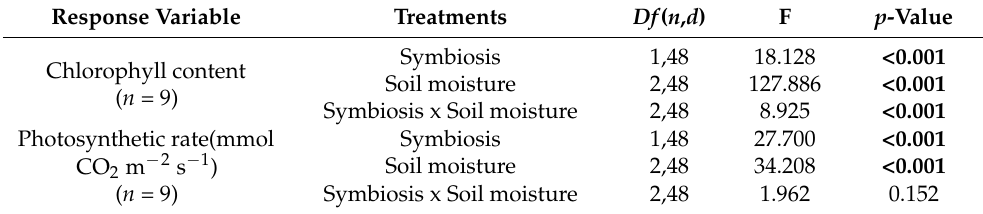
Figure 2. Validation of the expression changes (log 2 (fold change, FC)) and a heatmap (FC > 1.5, plus) of selected genes involved in the processes of photosynthesis and photosynthesis-antenna proteins from RNA-Seq using qRT-PCR under normal (CK, ( A )), moderate drought (MD, ( B )), and severe drought (SD, ( C )) moisture treatments. Note: The results are plotted for genes that show the significant upregulation and down regulation of leaves in response to the fungal endophyte under different soil moisture levels ( D ); a plus indicates the upregulated DEGs in Epichloë symbiotic (EI) versus non-symbiotic (EF) plants under CK, MD, and SD moisture treatments. The linear trend line, the R-value, and 95% confidence interval are shown. Table 2. ANOVA table showing the effects of plant symbiosis status and soil moisture levels on the tiller number, biomass, chlorophyll content, and photosynthetic rate of Achnatherum inebrians plants symbiotic with the fungal endophyte Epichloë gansuensis